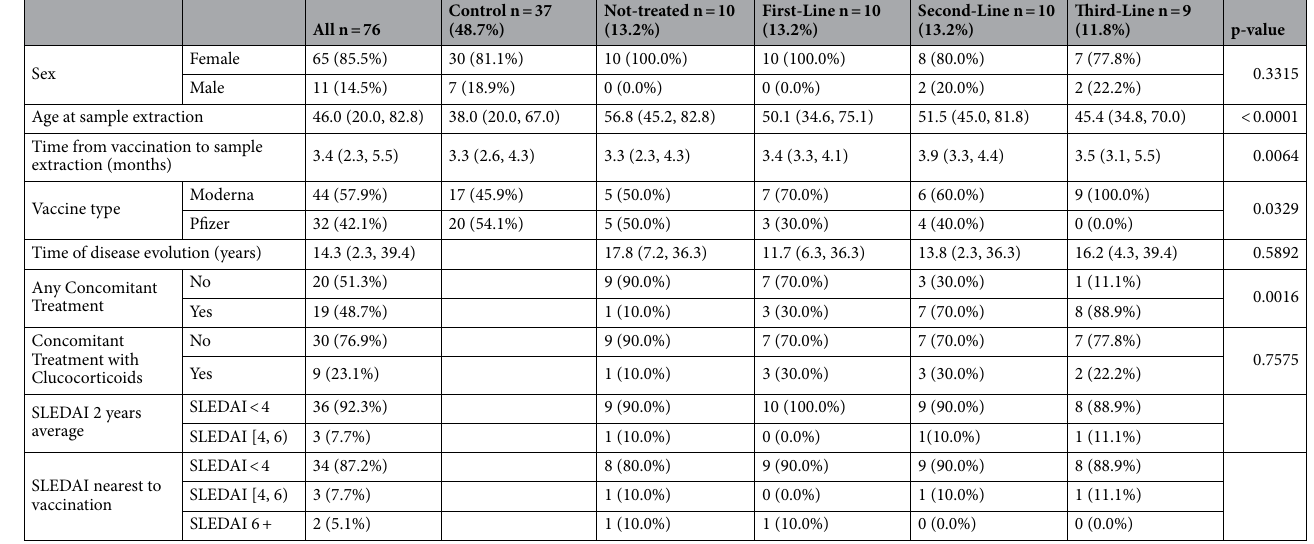
Table 1. Descriptive of subjects’ characteristics in the study according to disease and treatment status. Continuous variables are described by medians, minimum and maximum values; categorical variables are summarized using absolute frequencies and percentages. p-values are derived from a Mann–Whitney (continuous) or a Fisher’s test (categorical